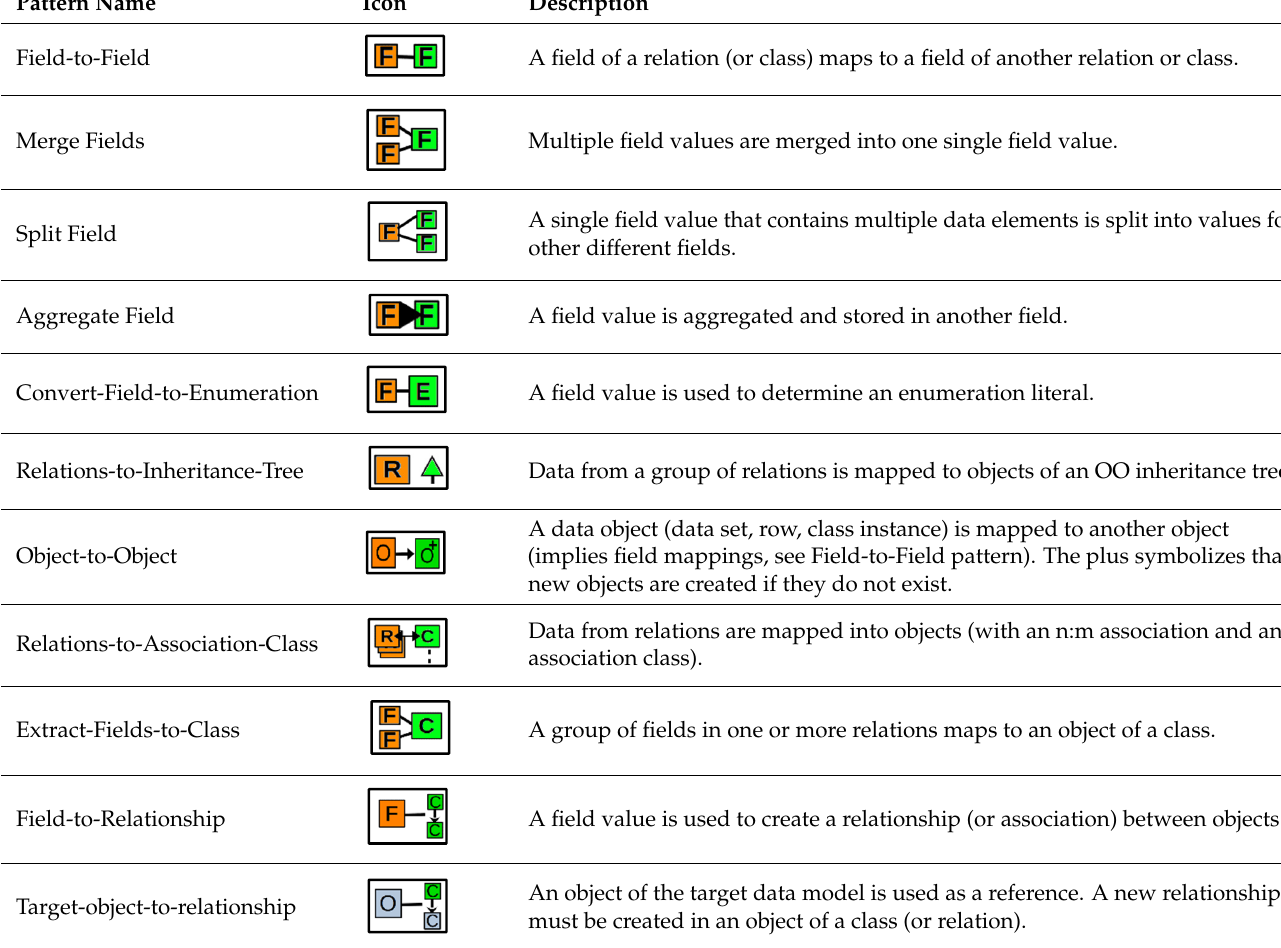
Table 1. Data integration patterns: source on the left side (orange) and target on the right side (green) [5].